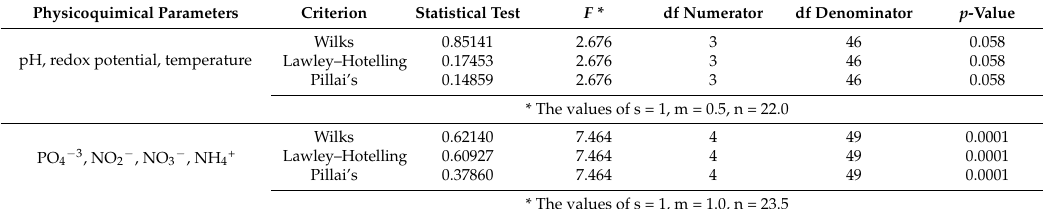
Table 2. Multiple analysis of variance (MANOVA), with a two-level factor, artificial wetland habitats with seawater (control) and urban residual wastes applied to physicochemical parameters of the interstitial water (Phase 3) ( p < 0.05). Physicoquimical Parameters Criterion Statistical